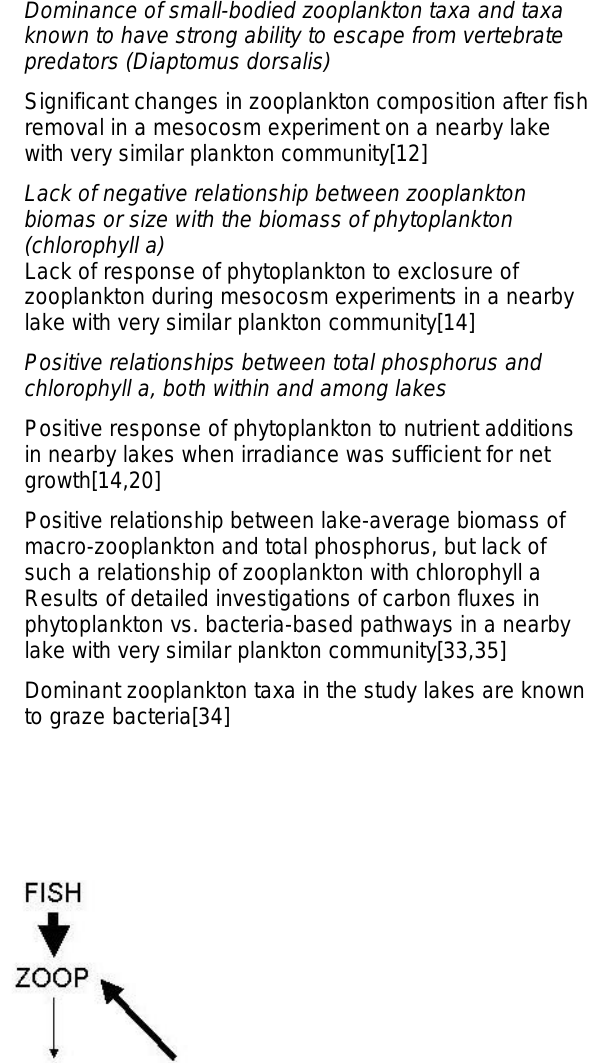
Hypotheses Regarding Consumer vs. Resource Control of Plankton in Florida Lakes,